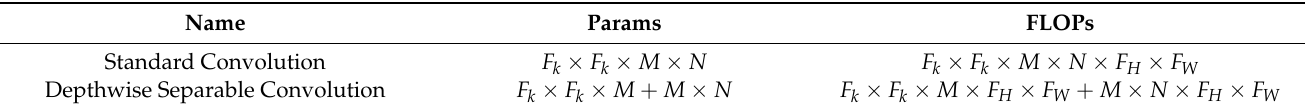
Table 1. Comparison of depthwise separable convolution and standard convolution.